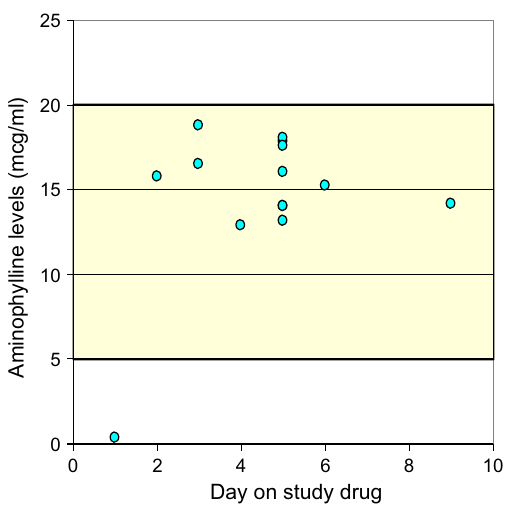
Figure 2: Serum concentrations of aminophylline